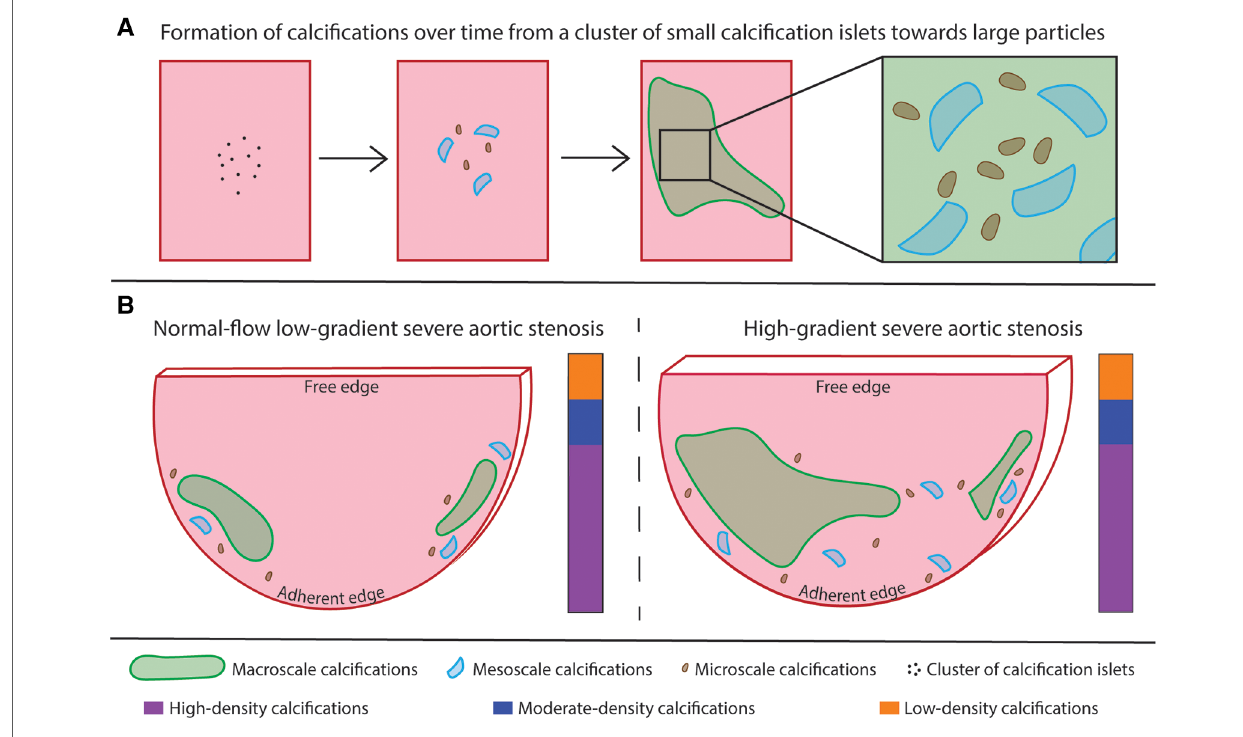
FIGURE 6 Summary scheme. ( A ) illustration of the hypothesis about the evolution of a cluster of small calci fi cation islets into dense calci fi cations over time. Large calci fi cations correspond to the accumulation of small particles. ( B ) comparison of the two patterns of calci fi cation. The calci fi cations are present in higher relative amount and the cusp is thicker in the HG-SAS group than in NF-LG-SAS. In the less calci fi ed samples, the calci fi cations are mainly located at the adherent edges of the cusp, while for the most calci fi ed samples, the midportion of the cusp is affected as well. The absolute volume of the largest calci fi ed particle is higher in the HG-SAS group than in NF-LG-SAS, but it corresponds to at least 50% of the total calci fi cation volume in all cases. The macroscale particles are present in equal number in both groups while the meso- and microscale particles are both present in higher number in the HG-SAS groups than in NF-LG-SAS. The calci fi cation density is evenly heterogeneous in both diagnosis groups (illustrated by the vertical